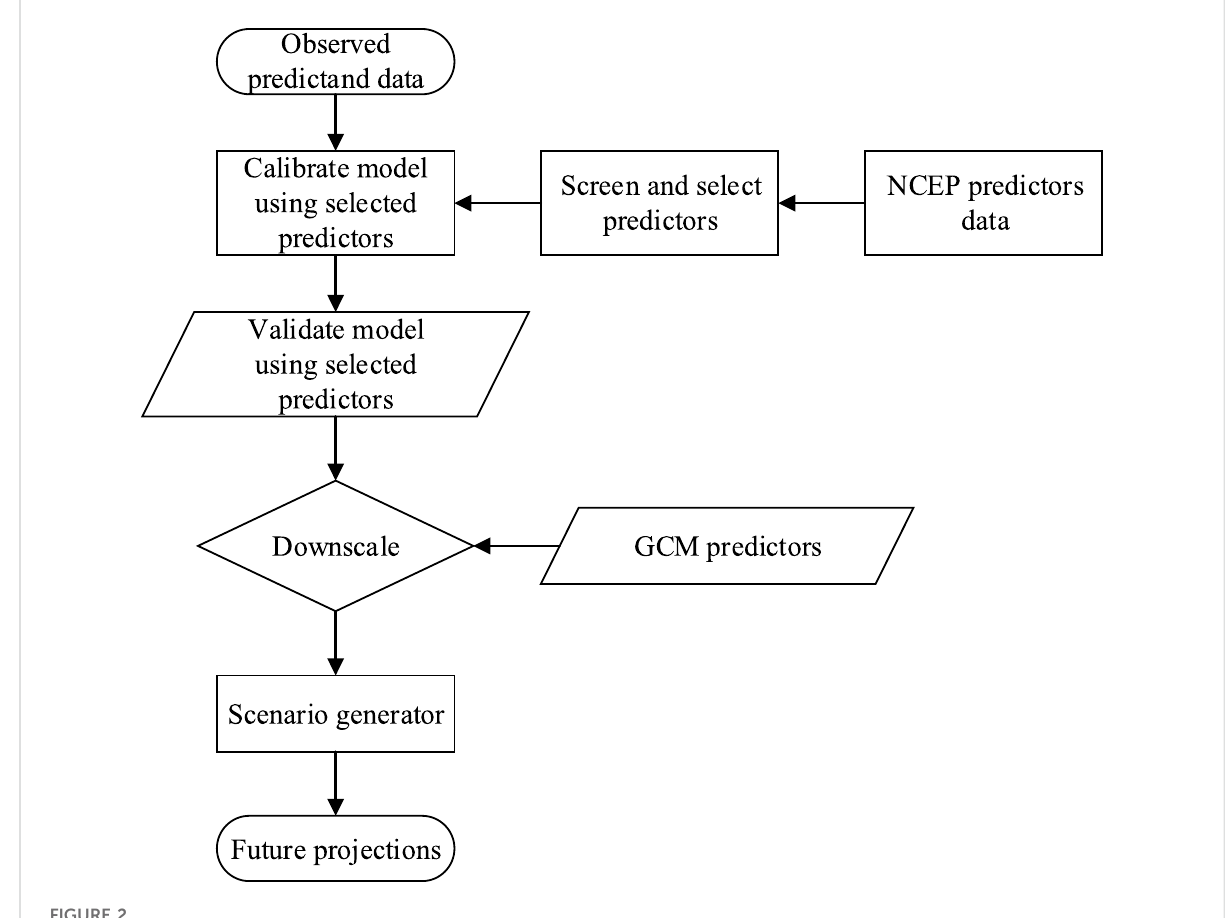
FIGURE 2 Methodology adopted by SDSM for downscaling and scenario